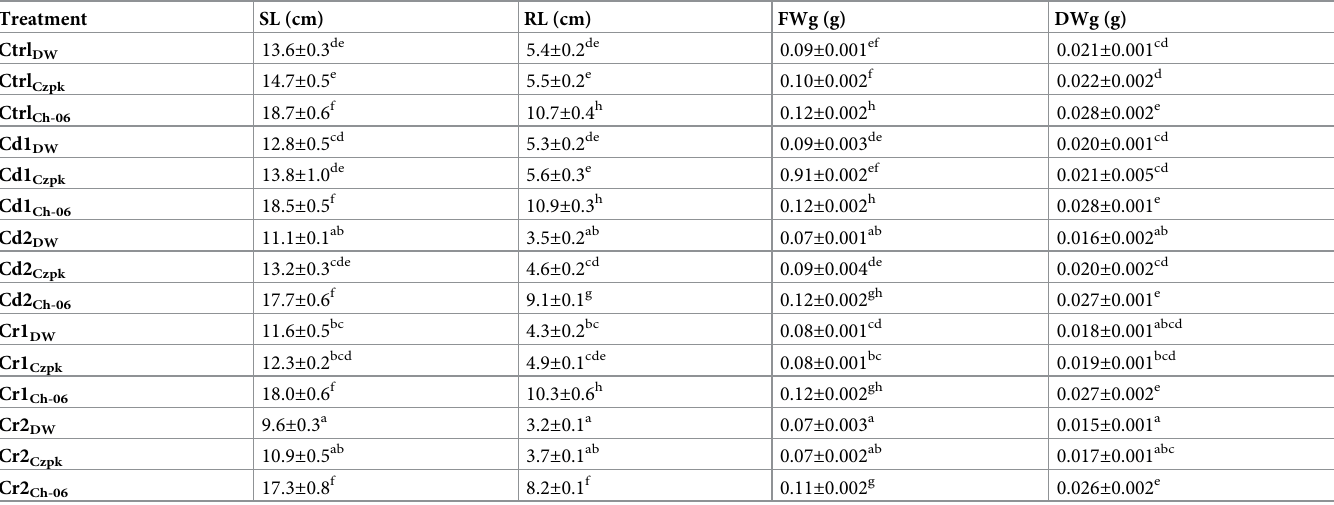
Table 3. Effect of Ch-06 on rice under Cd and Cr stress. Treatment